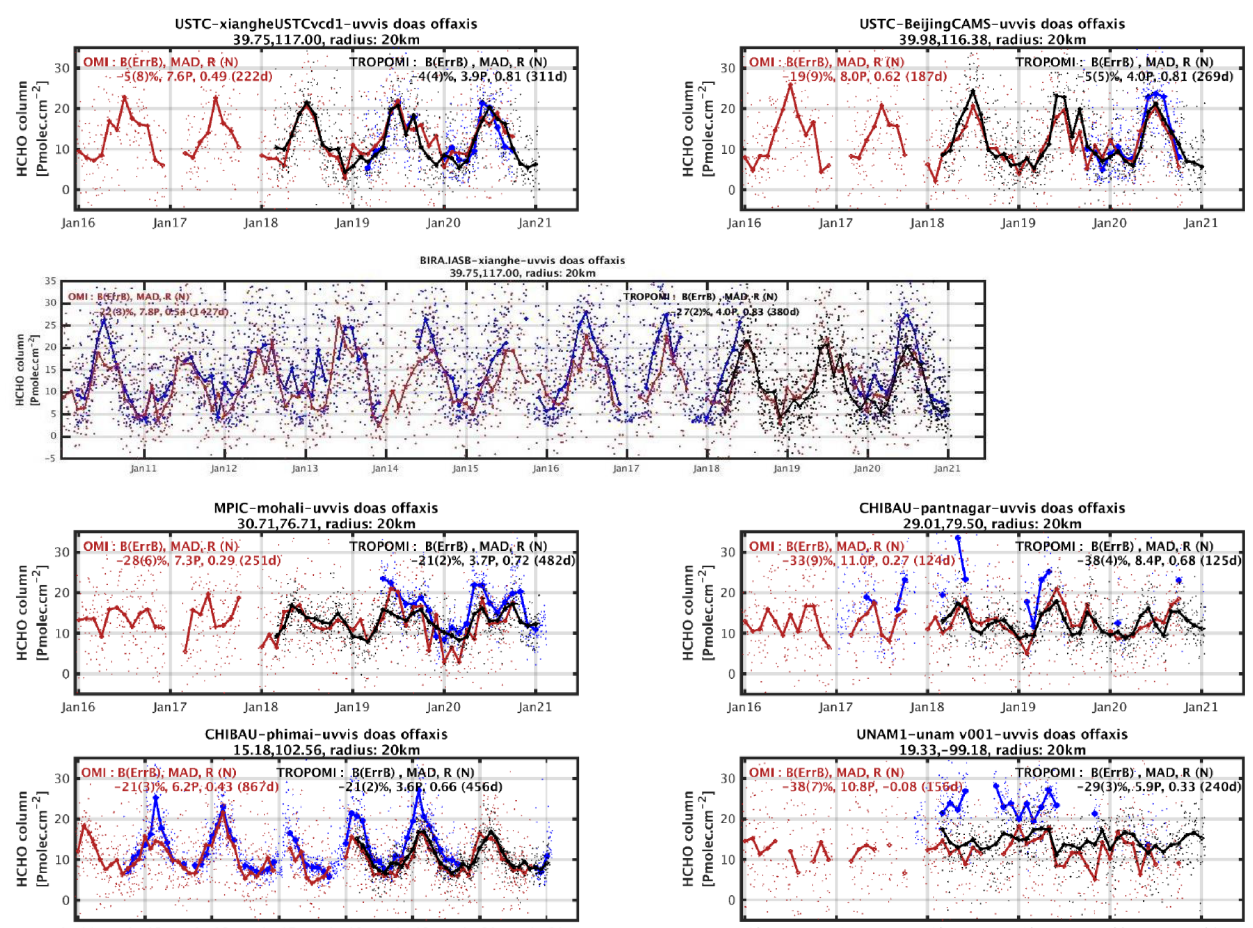
Figure 14. Same as Fig. 12 at Chinese, Indian, Thai and Mexican sites.